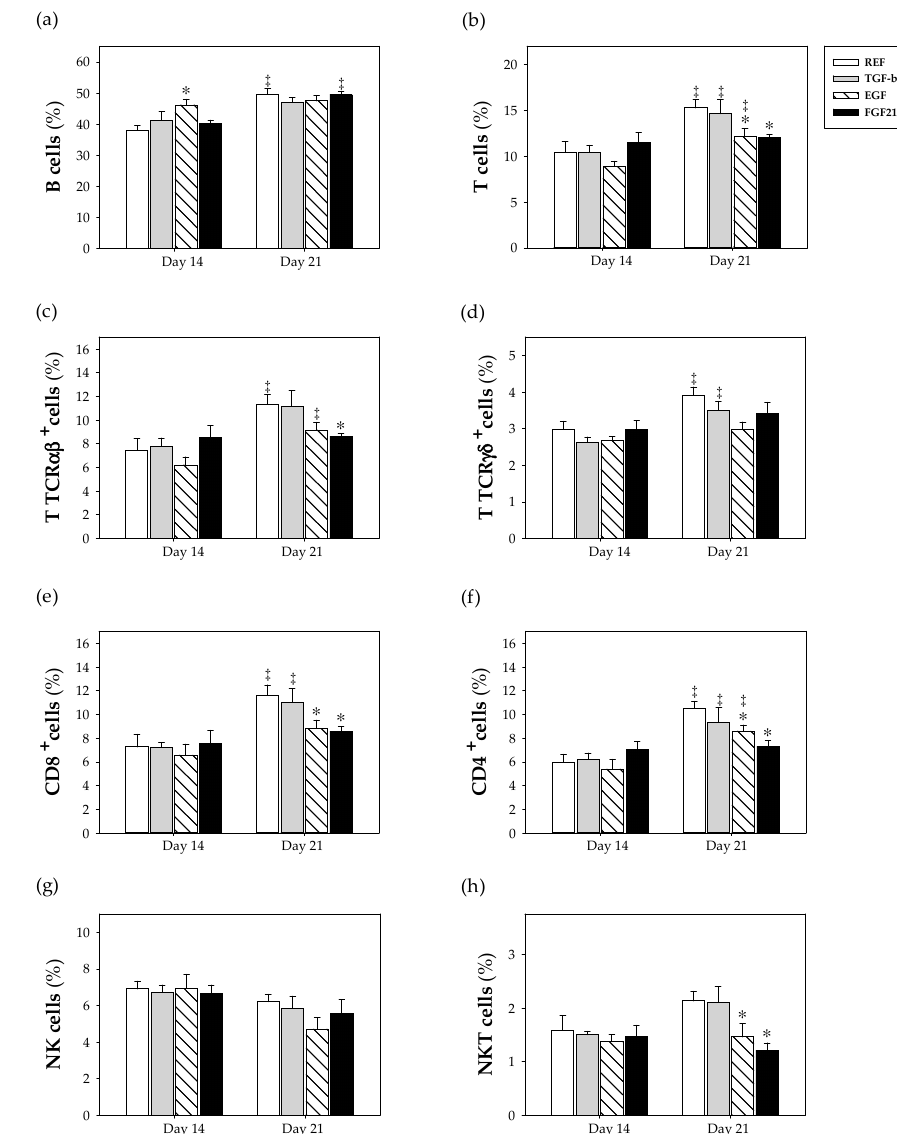
Figure 4. Effect of growth factor supplementation on the main spleen lymphocyte subsets from the four groups, i.e., reference (REF), transforming growth factor- β 2 (TGF- β 2), epidermal growth factor (EGF) and fibroblast growth factor 21 (FGF21), over the suckling period (day 14 and 21). ( a ) B cells, ( b ) T cells, ( c ) T TCR αβ + cells, ( d ) T TCR γδ + cells, ( e ) CD8 + cells, ( f ) CD4 + cells, ( g ) NK cells and ( h ) NKT